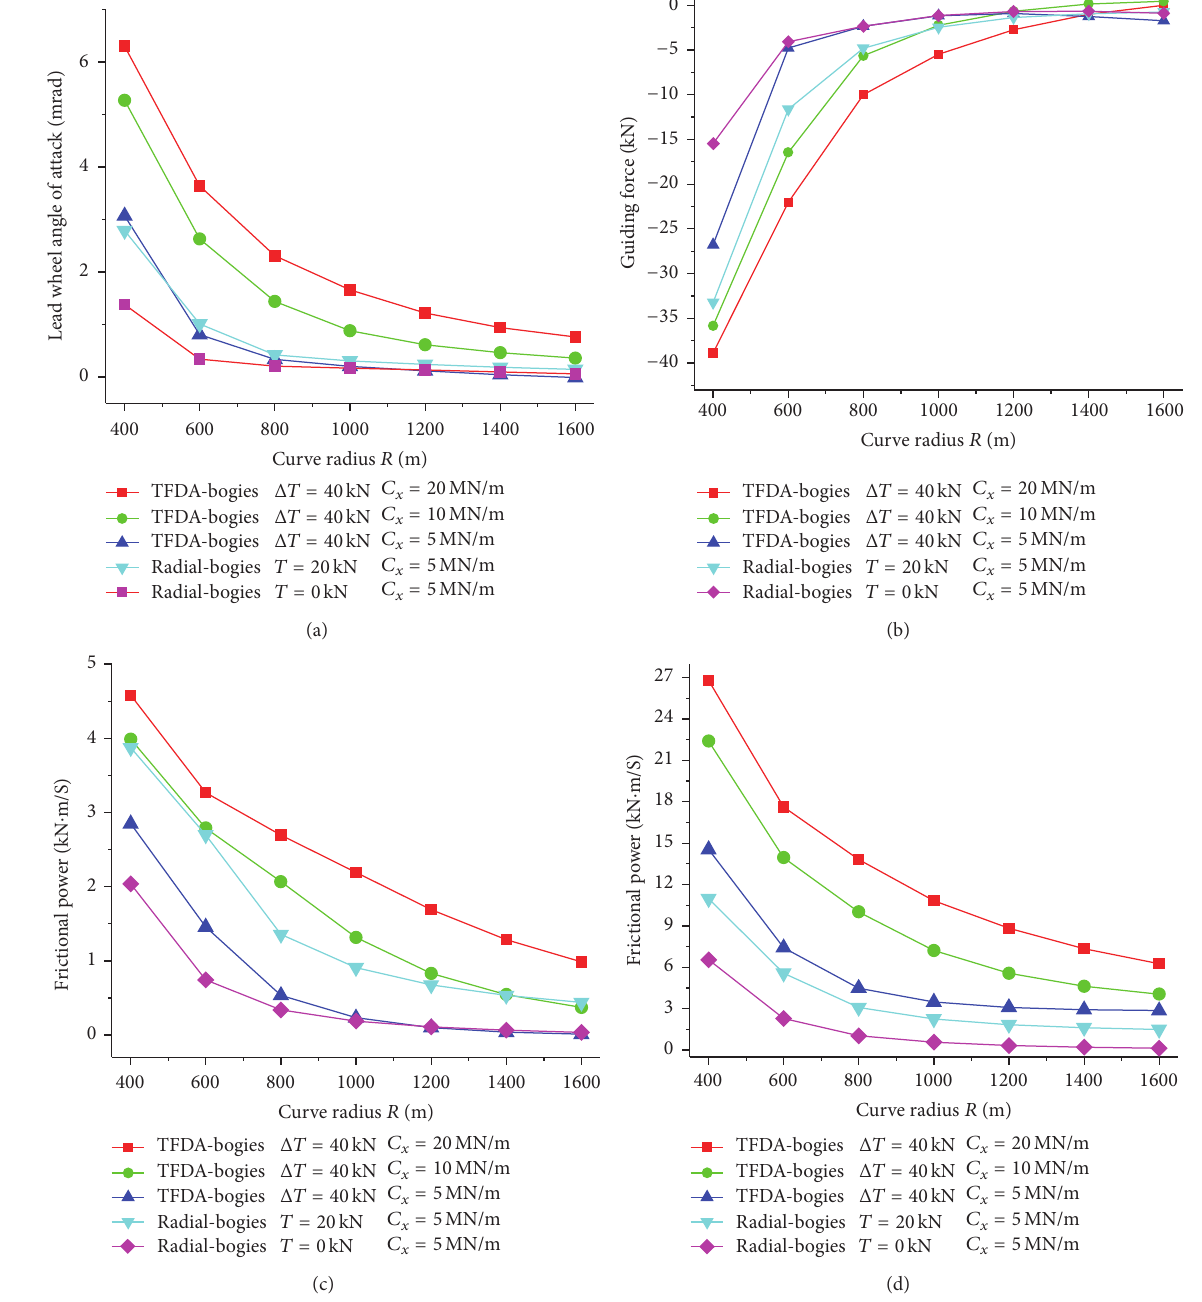
Figure 9: Each bogie performance comparison, (a) lead wheel angle of attack, (b) lead wheel lateral force, (c) lead wheel friction power, and (d) total vehicle friction